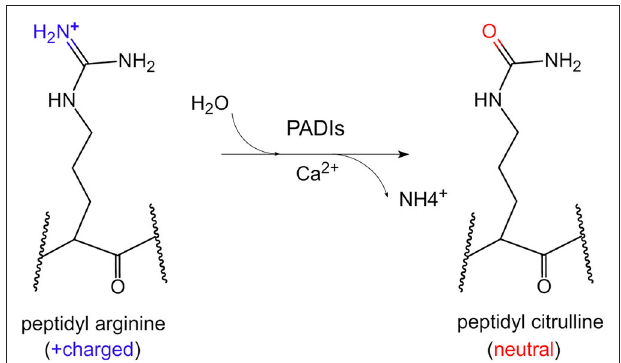
FIGURE 1 | The chemical conversion process of protein citrullination. In the presence of calcium ions, PADIs could catalyze the formation of peptidyl citrulline from peptidyl arginine, which removes an amino group, accompanied by the positive charge becoming electrically